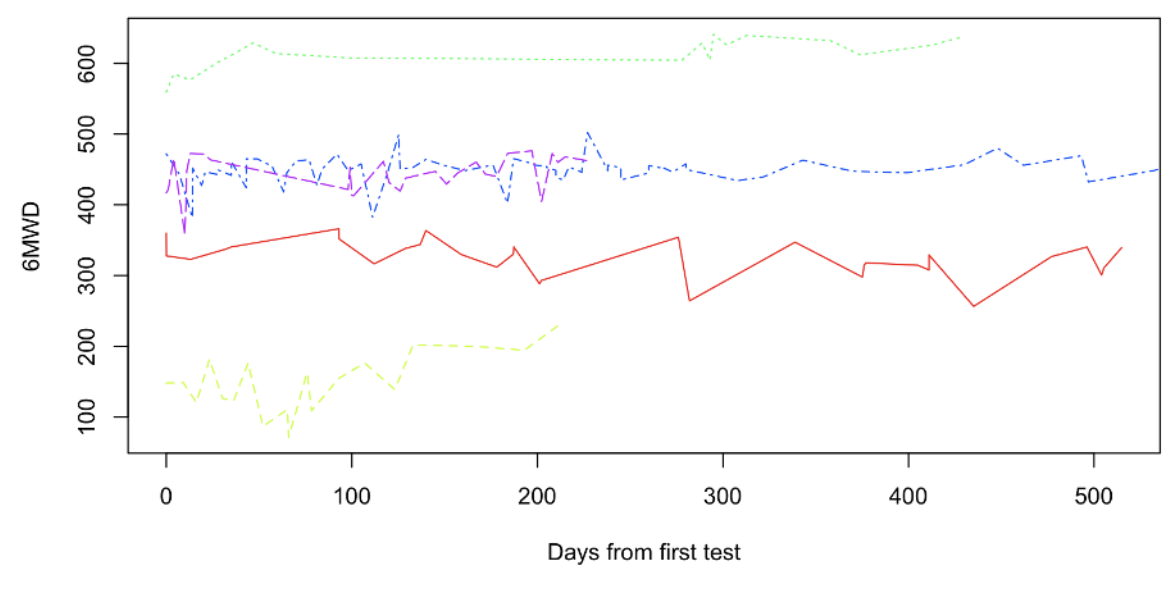
Figure 5. Outdoor, community-based 6-minute walk test distances over time of the top 5 patients who contributed with the most 6-minute walk tests. 6MWD: 6-minute walk test distance.